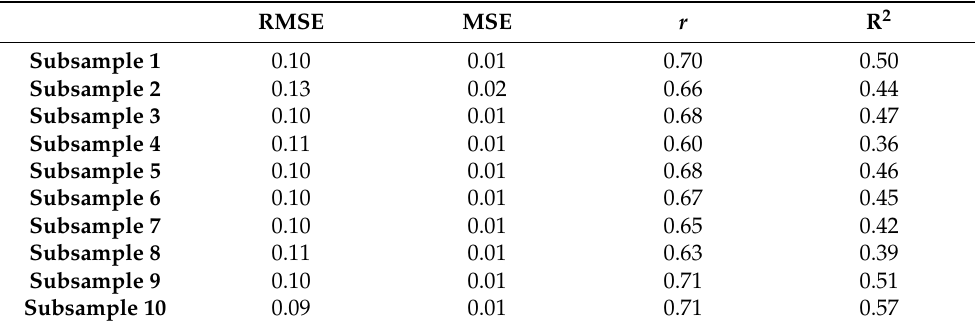
Table 4. Cross-validation: performance metrics of the Random Forest model evaluated in 10 training and testing subsamples. RMSE MSE r R